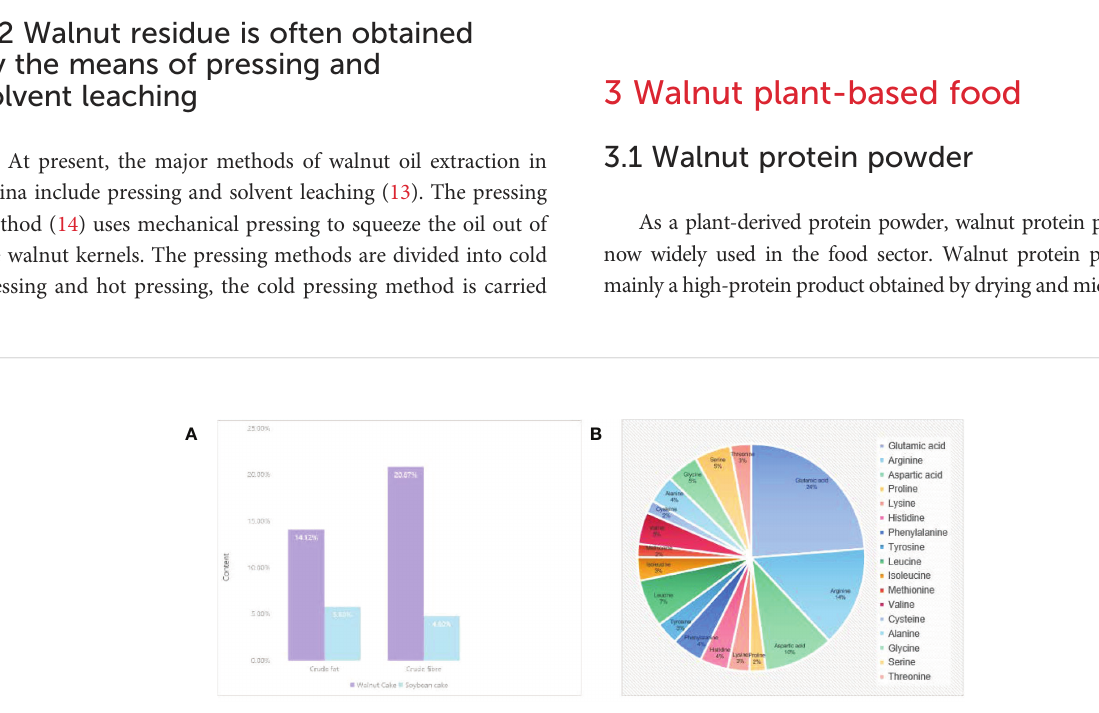
FIGURE 1 The main component of walnut residue. (A) Comparison of crude fat and crude fi ber in walnut residue and soya residue. (B) Composition and content of amino acids in walnut